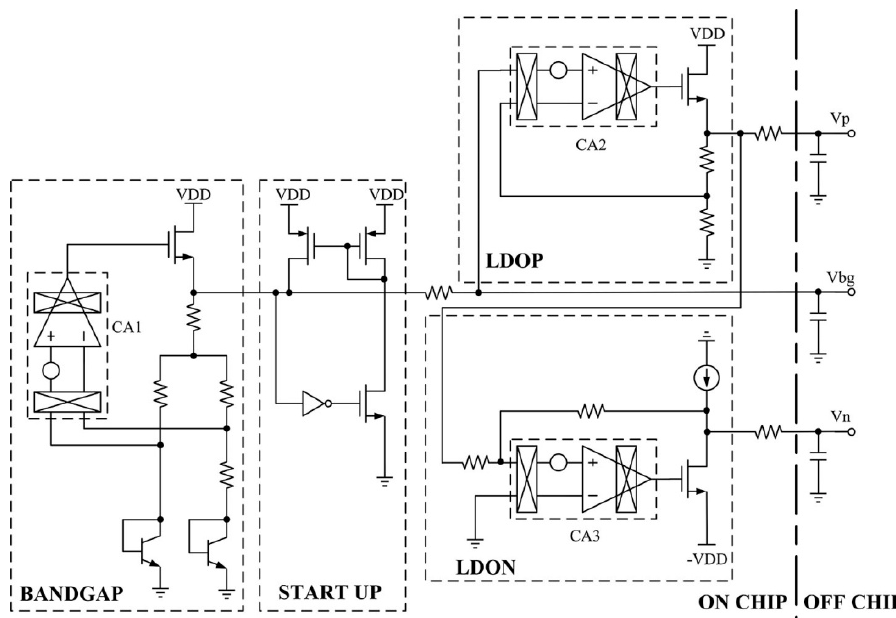
Figure 6. Block diagram of the voltage reference generator.